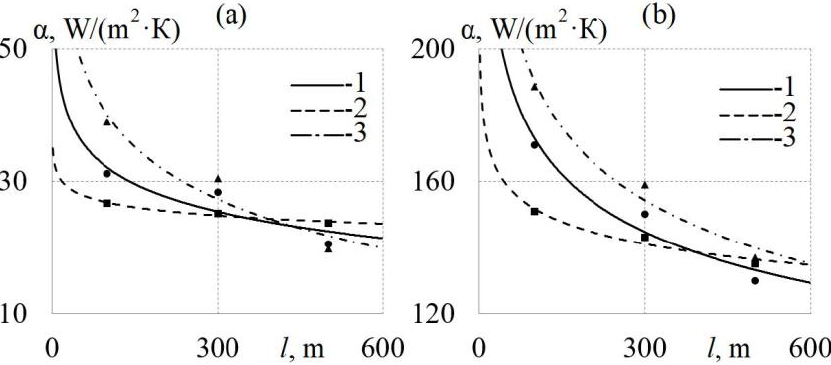
Figure 11. Dependences of the local heat transfer coefficient α along the length of (1) round, (2) square, and (3) triangular pipes for average air velocity w = 40 m/s and at initial values TI: ( а ) TI = 0.02; ( b ) TI = 0.12.